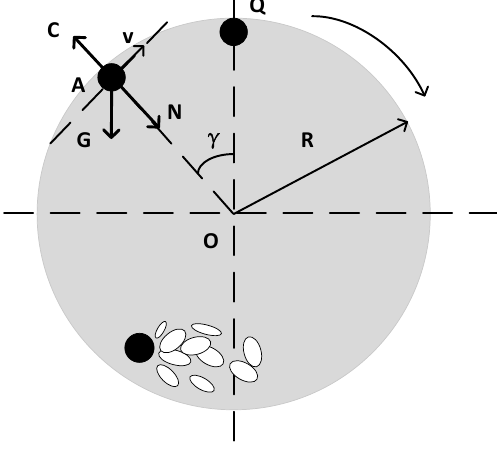
Figure 3. Force equilibrium of the grinding medium.